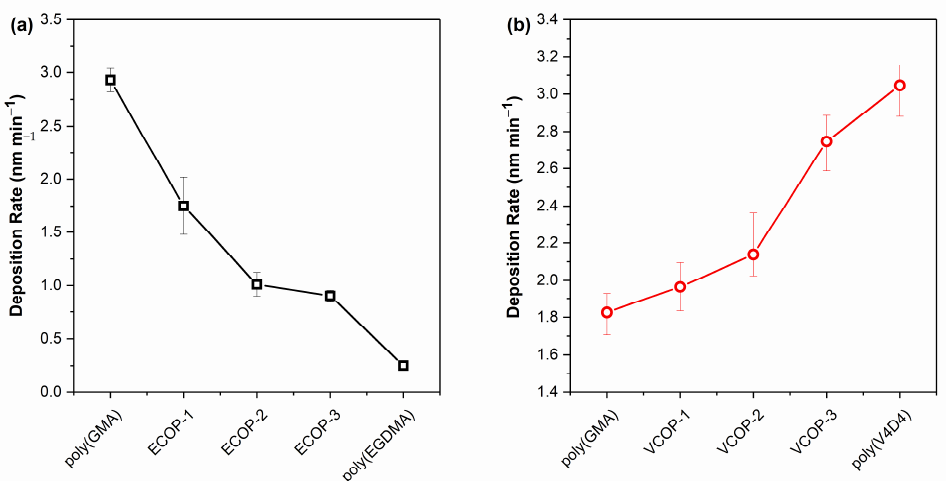
Figure 1. Deposition rates of ( a ) poly(GMA), poly(EGDMA) and ECOP (black squares), and ( b ) poly(GMA), poly(V4D4) and VCOP (red circles).